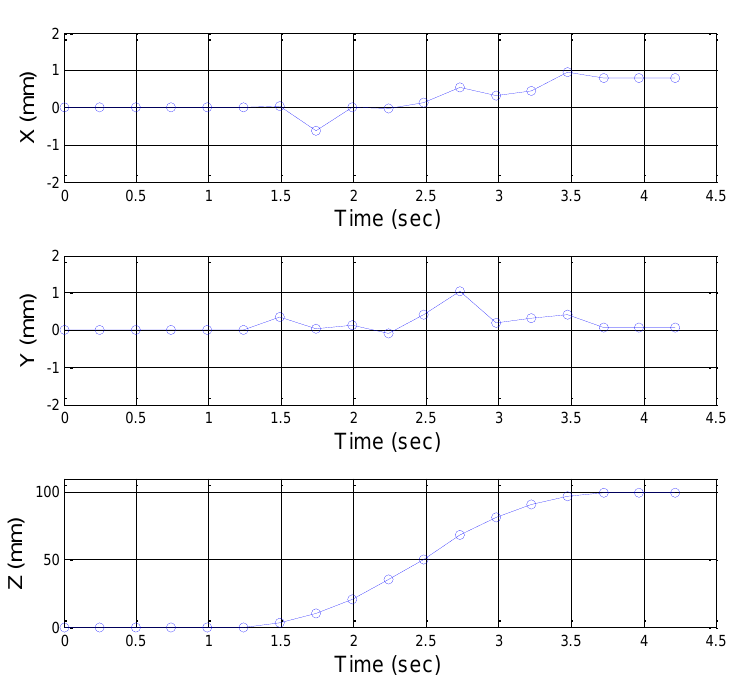
Figure 16. Stereo vision measuring results of a fifth order trajectory with stroke of 100 mm in the X-, Y- and